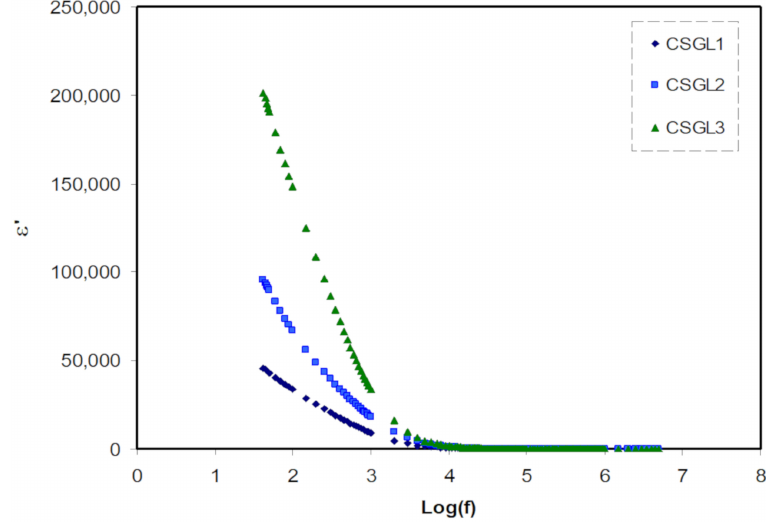
Figure 2. Dielectric constant versus log (f) for all polymer blend electrolytes.